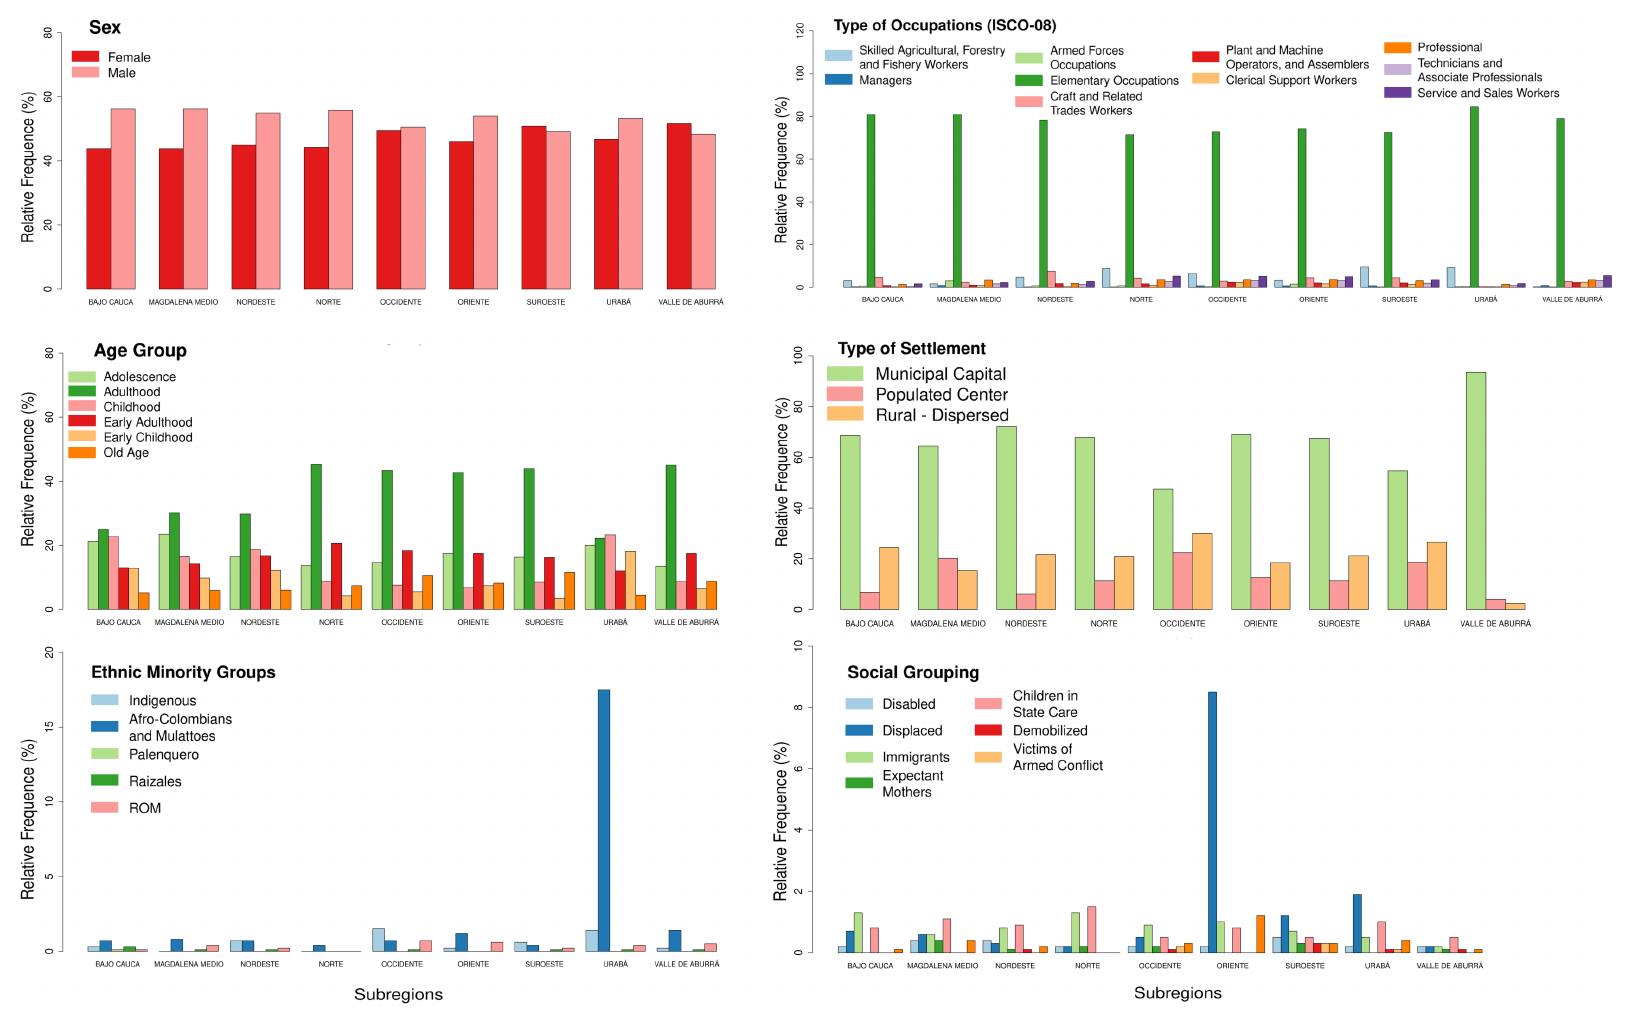
Figure 4. Barcharts for socio-demographic variables, discriminated by subregion, including sex, age groups, ethnic minority groups, type of occupation, and social grouping. For more details and p -values, we refer the reader to Tables 4 and